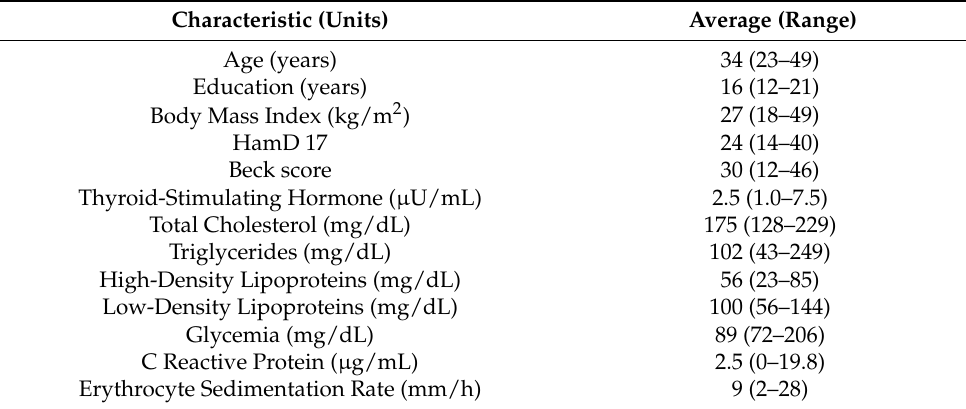
Table 1. Characteristics of the